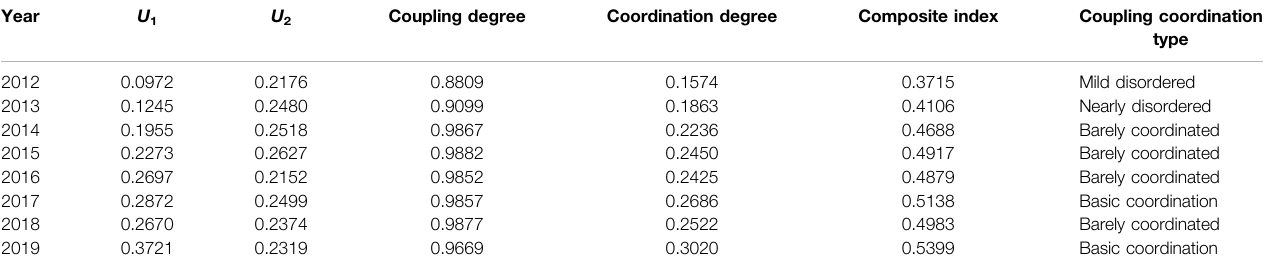
TABLE 6 | Comprehensive coupling coordination index of water – land resources in Zhangye.